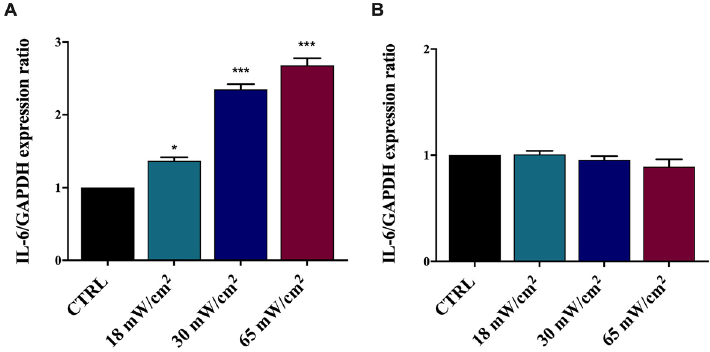
Figure 1. Real-time PCR analysis of IL-6 gene expression in HaCaT cells irradiated at 1 MHz for 1 h at varying I spta values and analysed at 0 ( A ) and 24 h ( B ) from the treatment. IL-6 gene expression was normalised to GAPDH, used as reference gene. A significant increase of IL-6 mRNA level was observed in HaCaT cells immediately after irradiation ( A ) but not after 24 h ( B ). The reported values and error bars represent the average and the standard deviation evaluated on each sample analysed. Asterisks indicate significant difference from the control sample (*p < 0.05, ***p < 0.001). The graph is representative of at least three independent experiments.